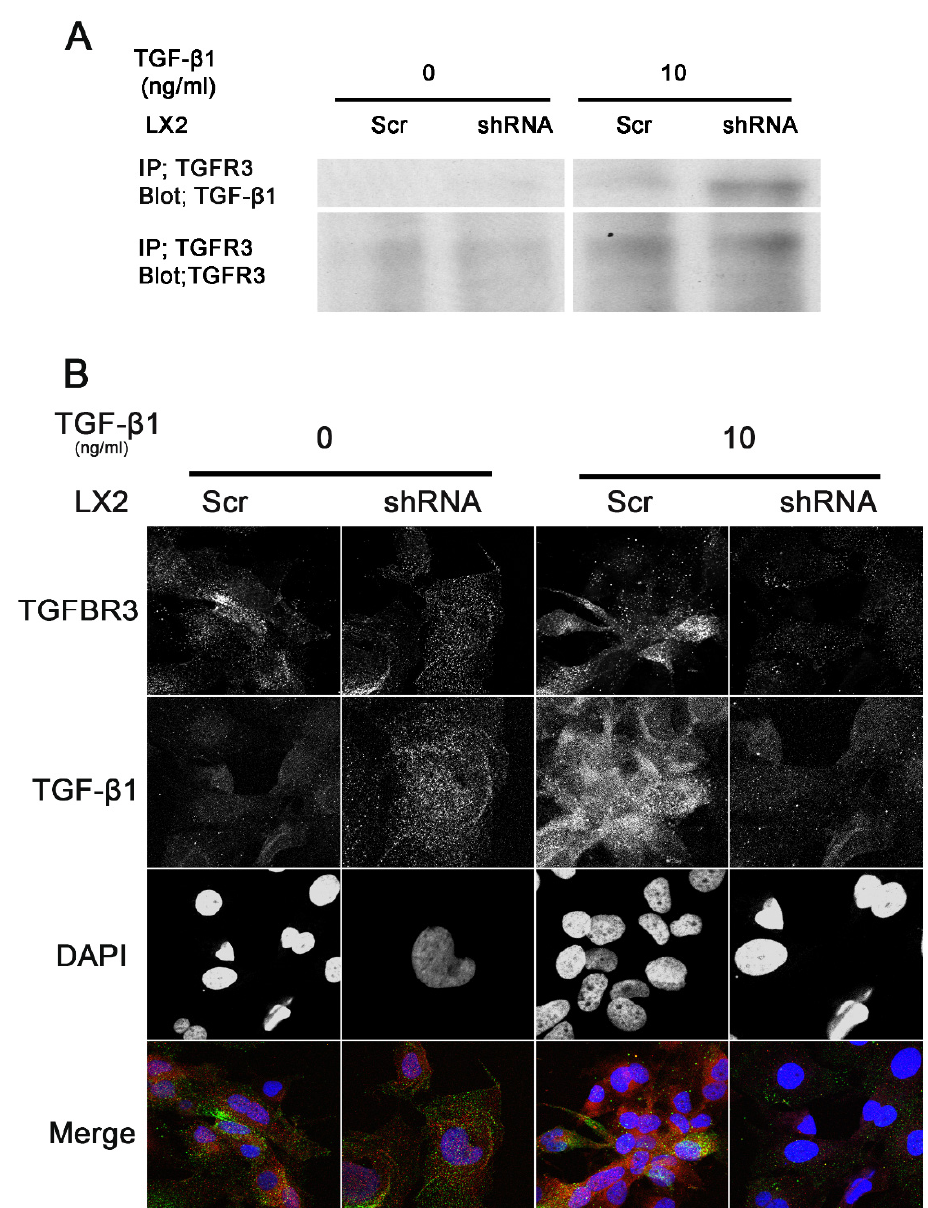
Figure 7. SULF2 modulates the release of TGF- β 1 from TGFBR3 (20 × ). ( A ) Immunoprecipitation shows that TGF- β 1 forms a complex with TGFBR3 and that SULF2 regulates this complex. ( B ) Im- munofluorescence shows that SULF2 modulates the release of TGF- β 1 from TGFBR3. HSCs were incubated in 1% FBS for 24 h prior to the addition of TGF- β 1 (2.5 ng/mL). Experiments were per- formed in triplicate. Representative micrographs are shown. Uncropped Western Blot figures are shown in Figure